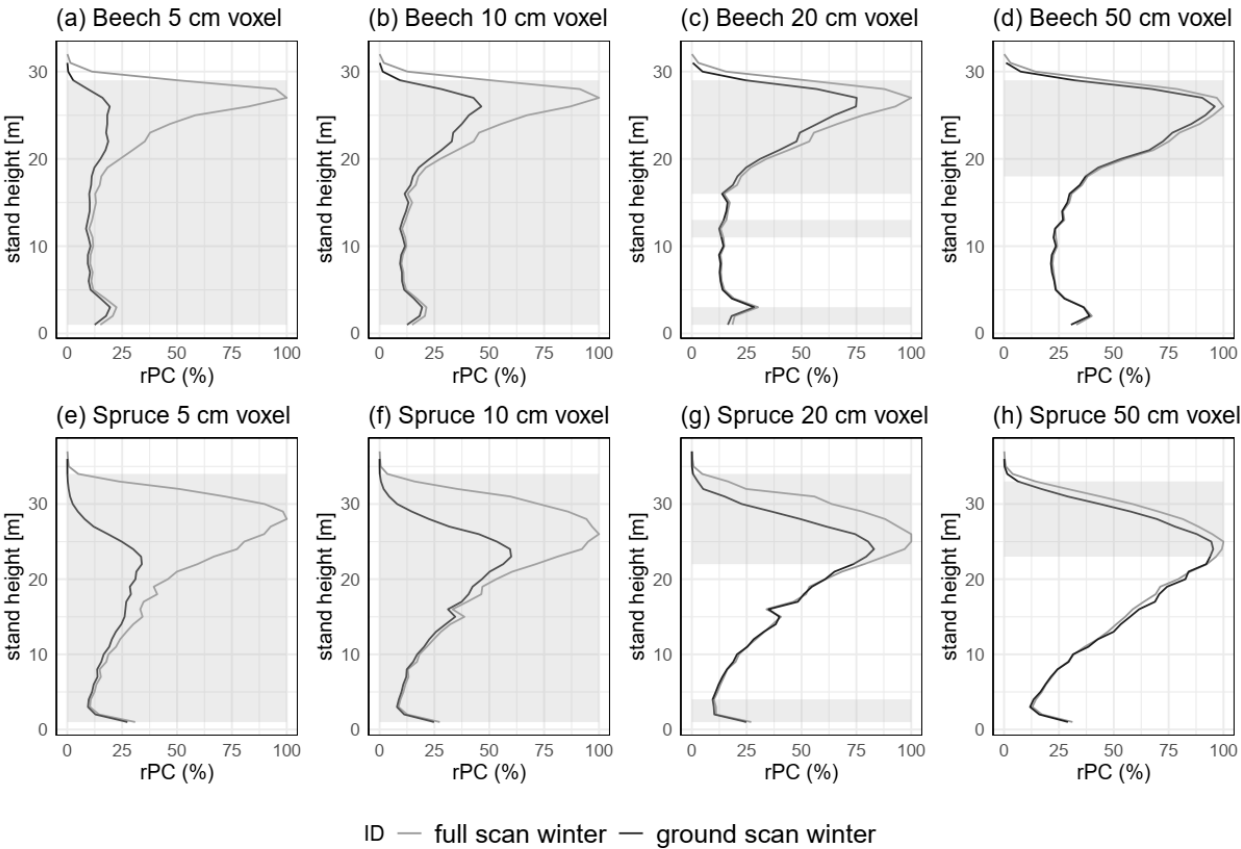
Figure 9. The relative point counts (rPC) with height for beech ( a – d ) and spruce ( e – h ) stands for the ground and full scans from winter. The black curve shows the relative counts over the height range for the ground scans, and the gray curve shows those for the full scans. The curves are based on six circular subplots, each with a radius of 5 m. Shaded in gray is the height range in which the scans differ significantly from each other.